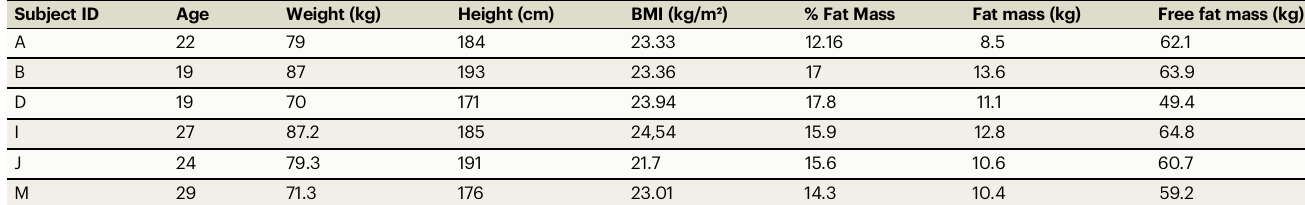
Table 1 | Anthropometry and body composition of the individuals enrolled in the clinical study